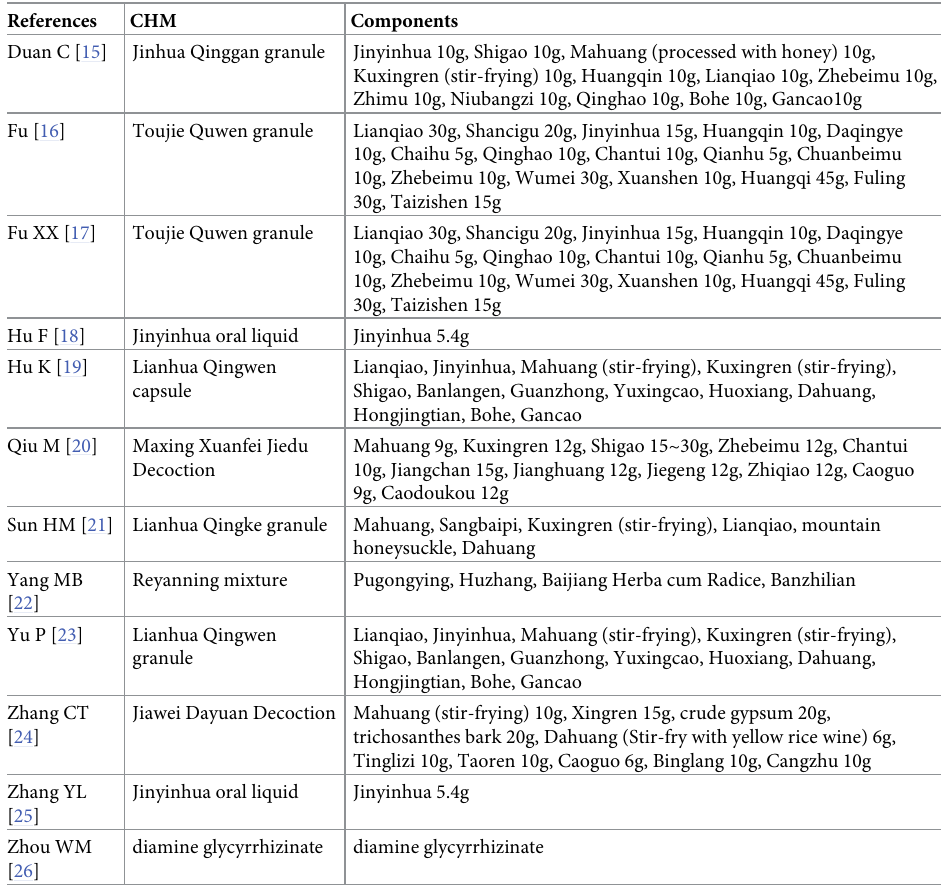
Table 2. The components of